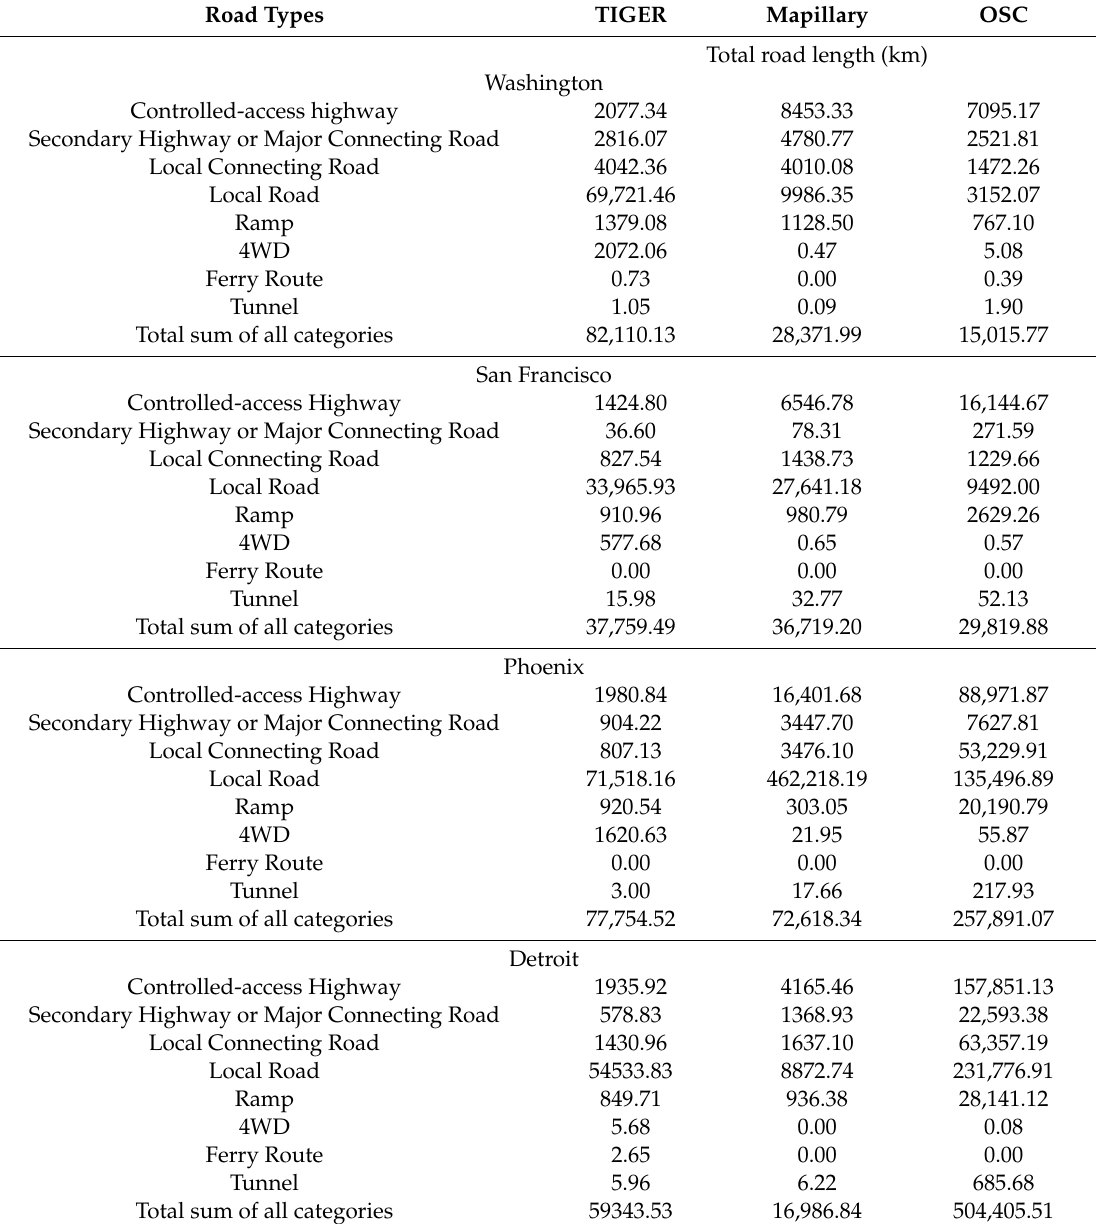
Table 6. Summary statistics for road